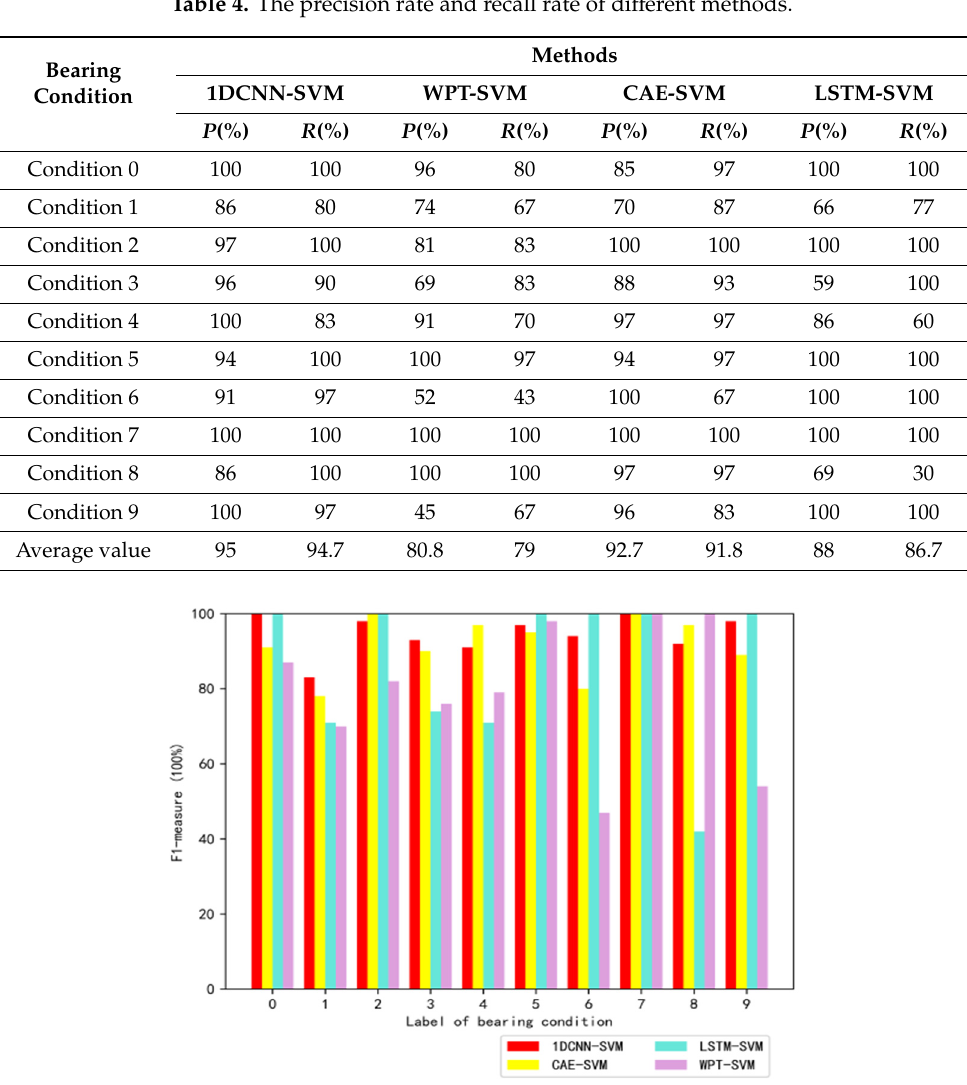
Figure 6. The F1-measures of the bearing data using different methods.